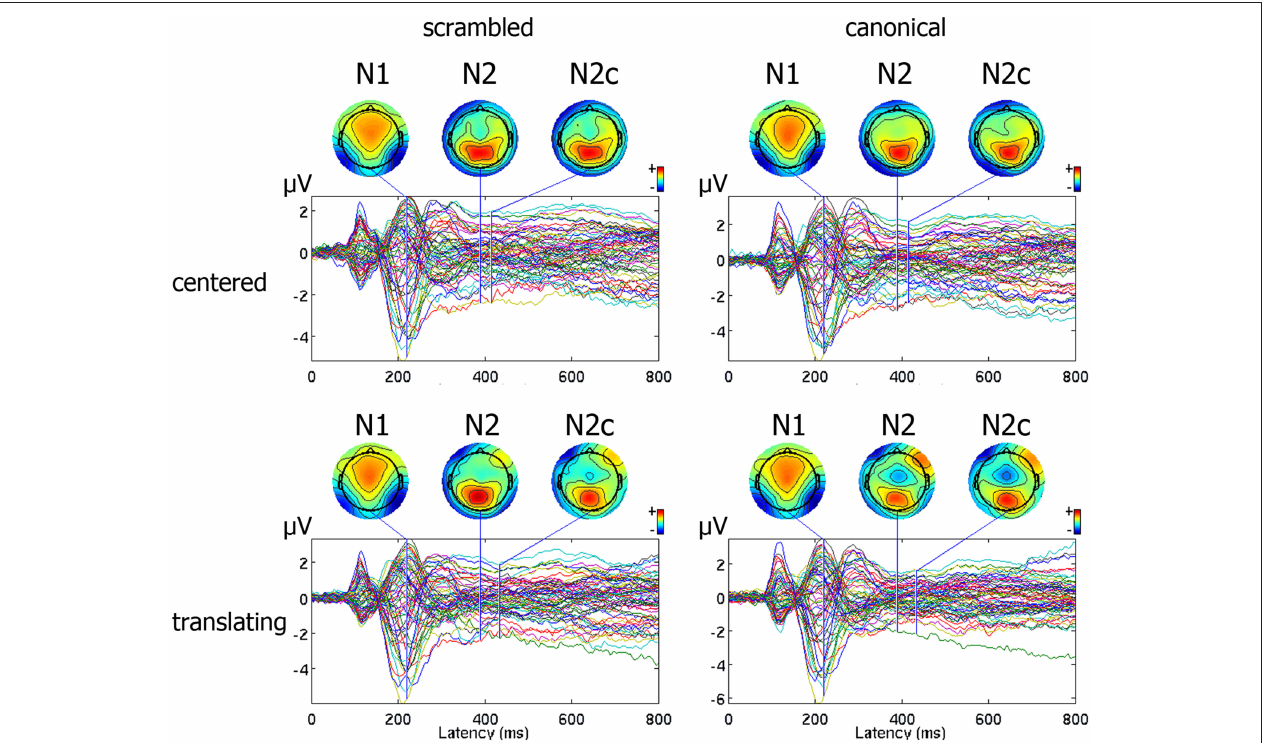
FIGURE 2 | Representation of ERP pattern. Data are represented as a butterfly plot, showing scalp maps at the onset of the classical N1 and N2 components and of the novel central N2, here labeled as N2c, and observed around the vertex only in the translating centered condition.